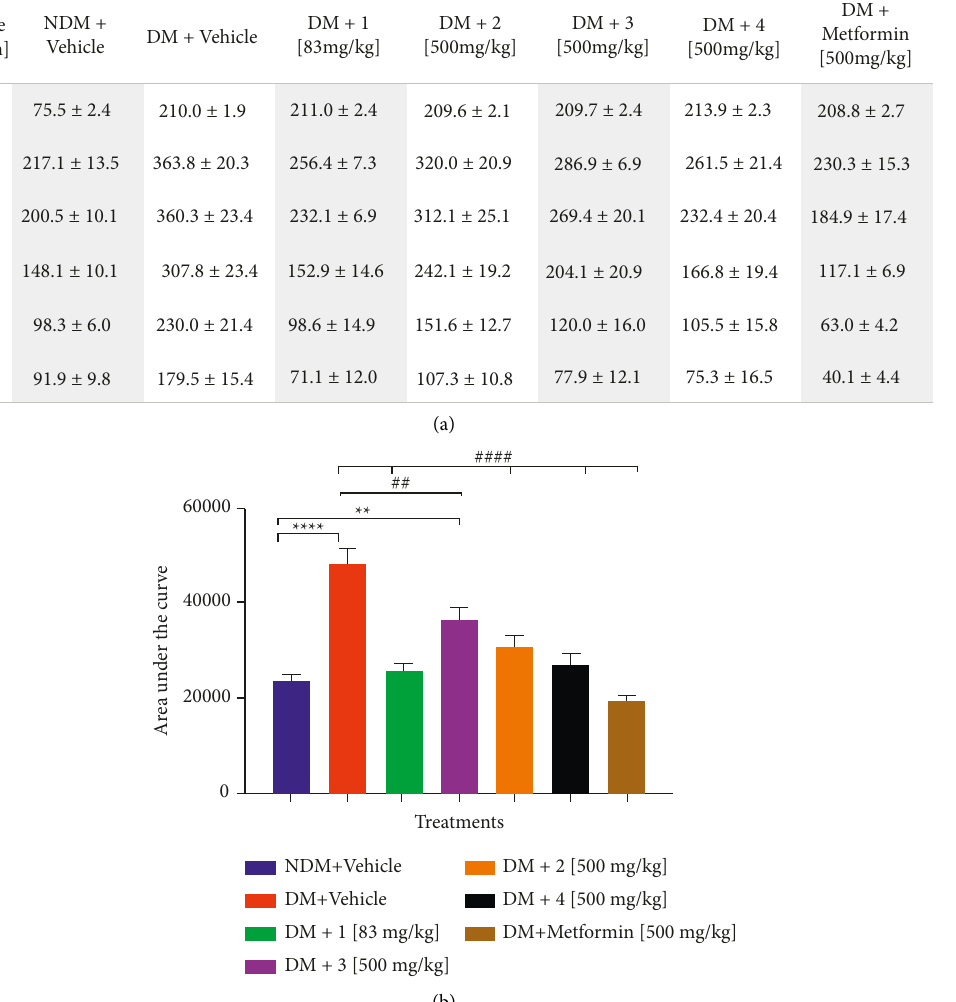
Figure 3: Effect of 1-4 cucurbitacins on glycemia. (a) Glycemia presented by treated groups during the glucose tolerance test curve of the evaluated groups; standard error mean of measurements for n 3. (b) Area under the curve of the glucose tolerance test as the integrated (cid:31) expression of the glycemia concentration; the error bars represent the standard error mean of measurements for n mice, DM diabetic mice, 1 23,24-dihydrocucurbitacin D, 3 2,16-diacetyl-23,24-dihydrocucurbitacin D, 2 ± (cid:31) (cid:31) (cid:31) 23,24-dihydrocucurbitacin D, and 4 2-O- β (2,3,4,6-tetracetyl) glucopyranosyl-16-acetyl-23,24-dihydrocucurbitacin D. The bars show the (cid:31) SEM. and show significance at p 0 . 01 and p 0 . 0001, respectively, versus NDM+vehicle; ## and #### show significance at p and p 0 . 0001, respectively, versus DM+ ∗∗ ∗∗∗∗ ≤ ≤ ≤